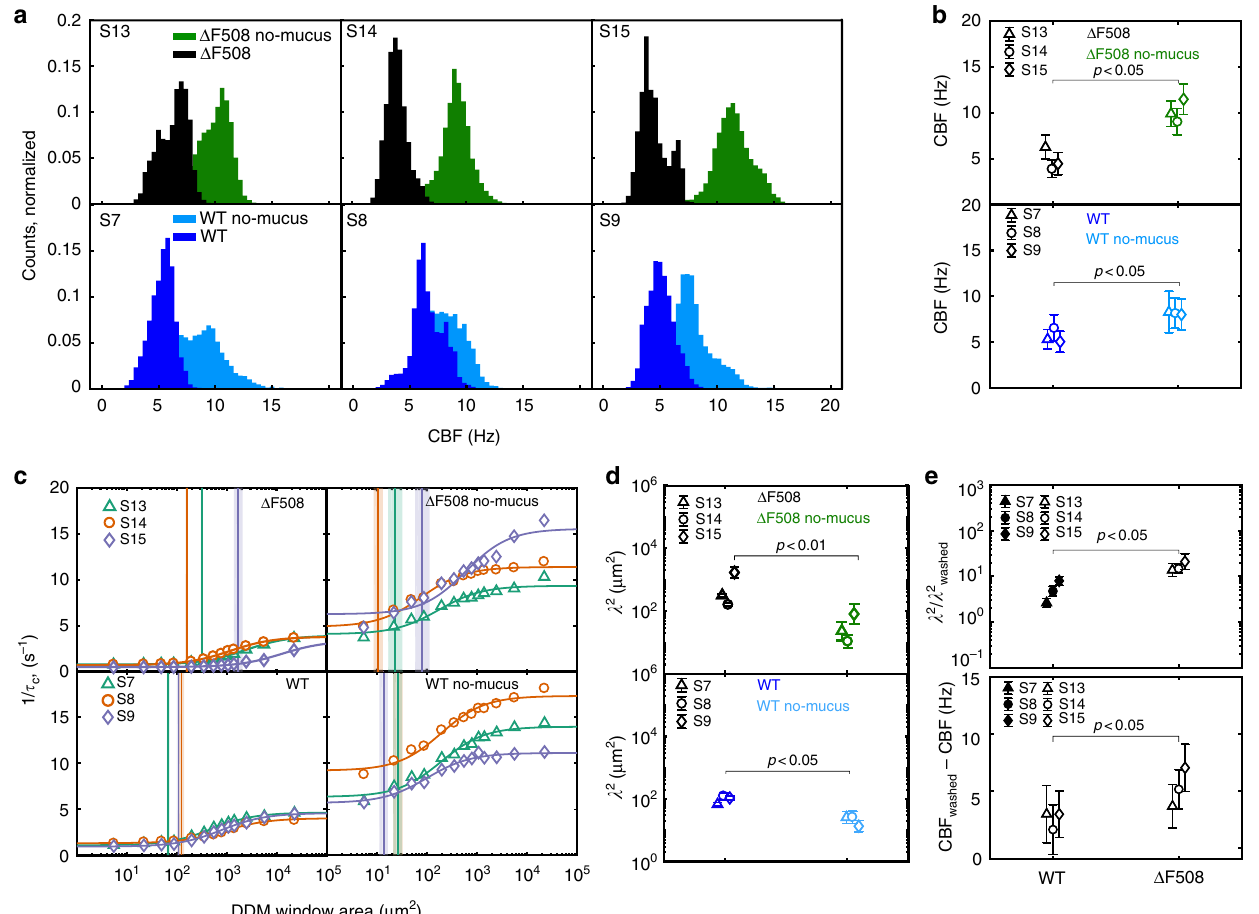
Fig. 2 Rheological properties of mucus affect both CBF and length scale of ciliary coordination. a Distribution of CBF for both samples from patients with CF ( Δ F508/ Δ F508) and healthy subjects. Each distribution was built from at least 20 FOVs imaged across the respective sample. b Mean and standard deviation for the CBF measured before and after mucus removal on each of the three separate healthy donors (S7, S8, S9) and CF (S13, S14, S15). p -value is calculated with paired, one-tailed Student ’ s t -test. c Sigmoidal curves of the decay rate τ c − 1 as a function of the tile for samples obtained from three subjects with CF ( Δ F508/ Δ F508) (top) and three healthy subjects (bottom), before and after mucus removal (left and right, respectively). Experimental data are shown as symbols (for the sake of visual clarity, error bars showing 25th and 75th percentiles are omitted), and the sigmoidal fi t is shown as a continuous line. The vertical line represents the left shoulder point and marks the coordination length scale squared λ 2 , and the shaded area its uncertainty. Each sigmoidal curve is built from up to 20 FOVs imaged across the sample. CF samples are characterised by a higher length scale of ciliary coordination than healthy samples; however, this effect is only apparent in the presence of mucus. d Comparison of the λ 2 for each sample shows the decrease in coordination length scale upon washing of the mucus layer. p -values calculated with paired, two-tailed Student ’ s t -test. e The change in coordination length scale (top) upon mucus washing is signi fi cantly different in CF vs healthy samples (unpaired, two-tailed Student ’ s t -test comparing log10 ( λ 2 )). The same is true for the change in CBF (unpaired, one-tailed Student ’ s t -test). All data shown in this fi gure were collected on bronchial primary